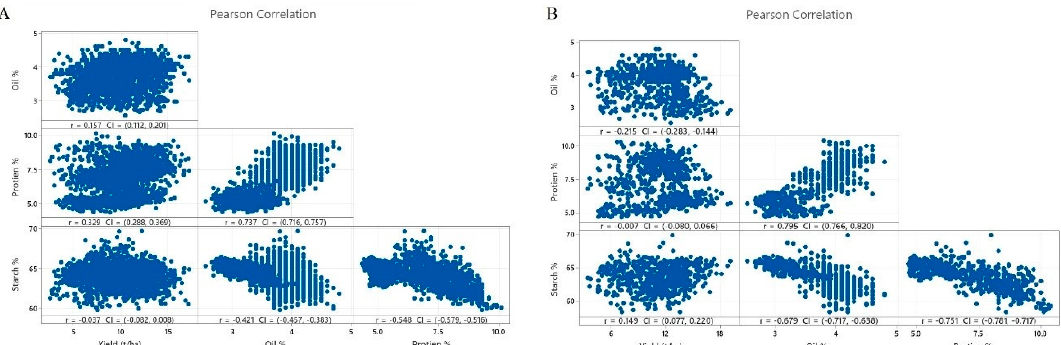
Figure 2. Correlation between the average values of the quality and quantity parameters of the hybrids in three years. ( A ): NPK fertilizer. ( B ): N fertilizer. Additive Main effects and Multiplicative Interaction (AMMI) analysis showed a sig- nificant effect of the genotypes, the effect of NPK × genotype interaction, and the effect of